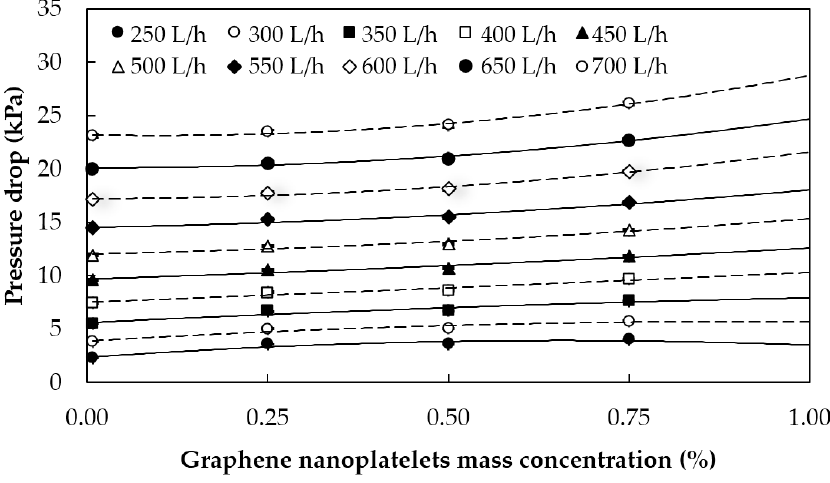
Figure 10. Pressure drops versus graphene nanoplatelet concentration at 35 °C test fluid temperature and for different flow rates.